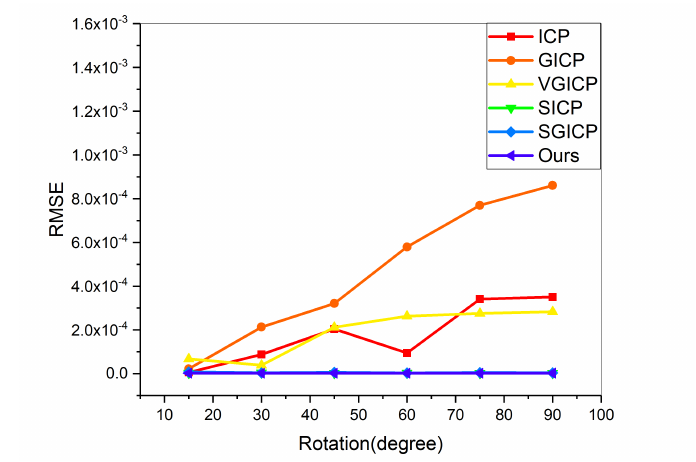
Figure 9. Controlled comparison between algorithms on rotation perturbation. ICP, Super4PCS-ICP (SICP), Super4PCS-GICP (SGICP) and our method obtain almost the same RMSE.